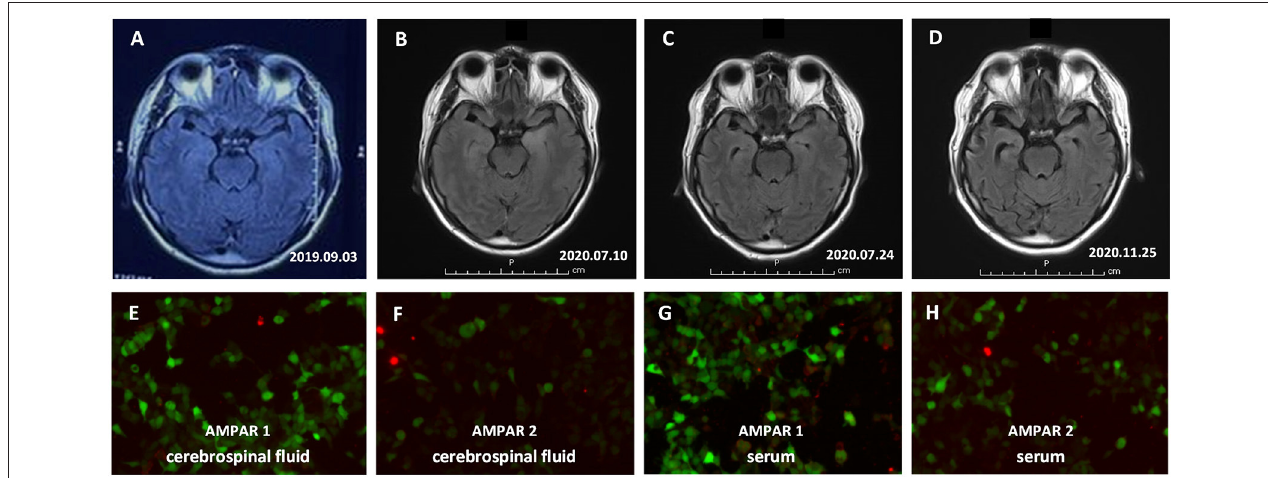
FIGURE 1 | The result of Brain MRI and Anti-alpha-amino-3-hydroxy-5-methyl-4-isoxazolepropionic acid (AMPAR) antibodies in the serum and cerebrospinal fluid (CSF). (A–D) Brain MRI showed high signal changes on fluid-attenuated inversion recovery sequences predominantly affecting the bilateral medial temporal lobe combined with some parts of the temporal cortex and progressive brain atrophy. (A) At the onset of the disease; (B) Onset for more than 10 months; (C) After 2 weeks of hormone shock therapy; (D) Follow-up for 4 months after discharge. (E–H) Anti-AMPAR1 and Anti-AMPAR2 antibodies in the serum and CSF of the patient were positive, as tested by the CBA method. (E) Anti-AMPAR1 antibodies in CSF; (F) Anti-AMPAR2 antibodies in CSF; (G) Anti-AMPAR1 antibodies in serum; (H) Anti-AMPAR2 antibodies in